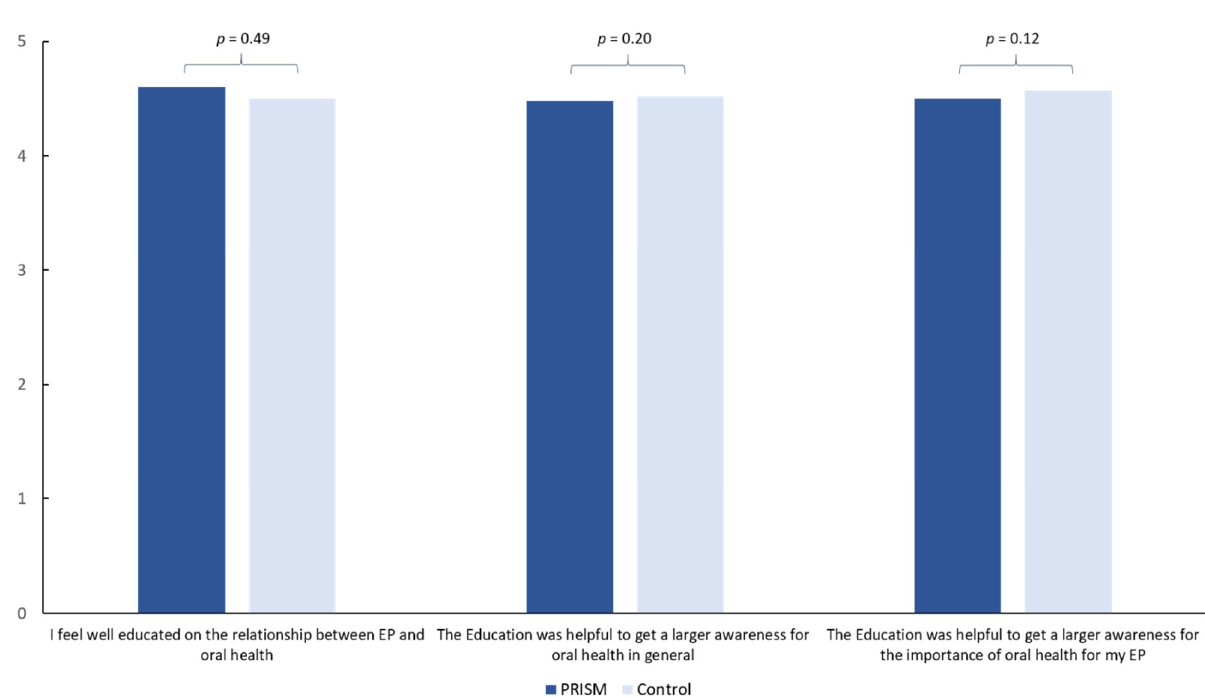
Figure 5. Perceived benefit of the education with either PRISM task or verbally (Control).